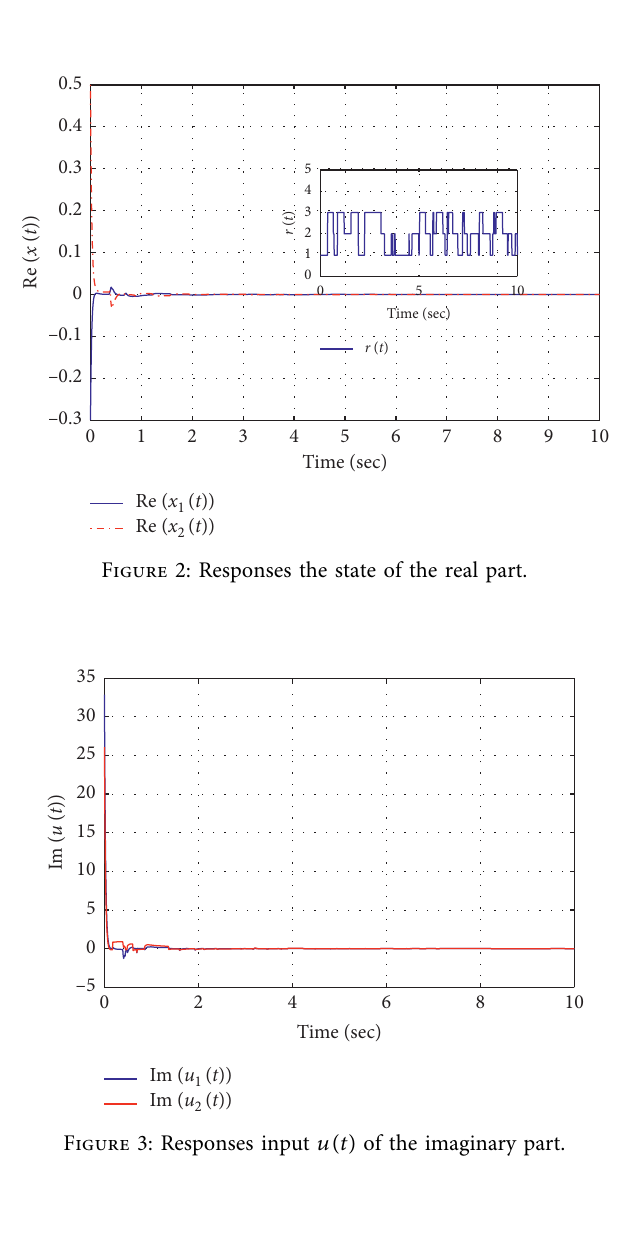
Figure 1: Responses the state of the imaginary part.